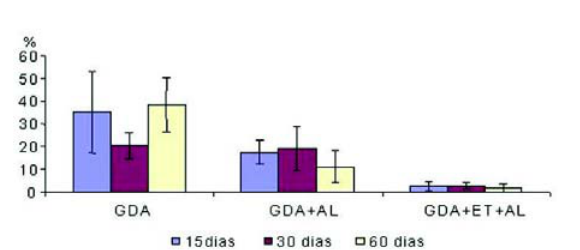
Fig. 6 - Análise morfométrica da calcificação dos condutos, nos três períodos